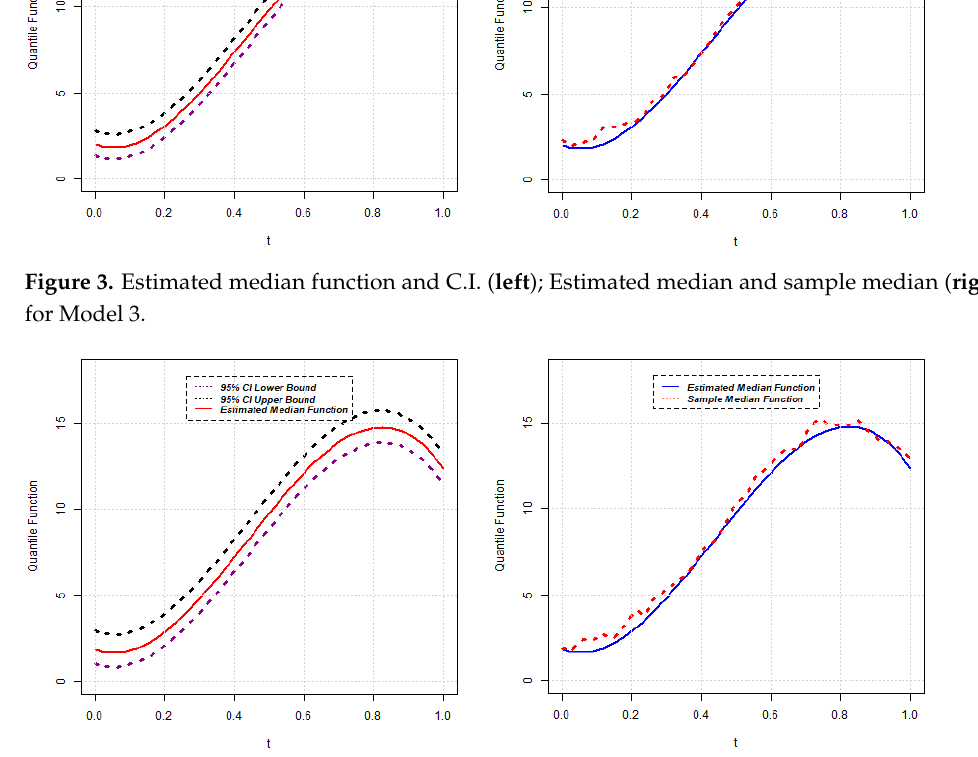
Figure 4. Estimated median function and C.I. ( left ); Estimated median and sample median ( right ) for Model 4.